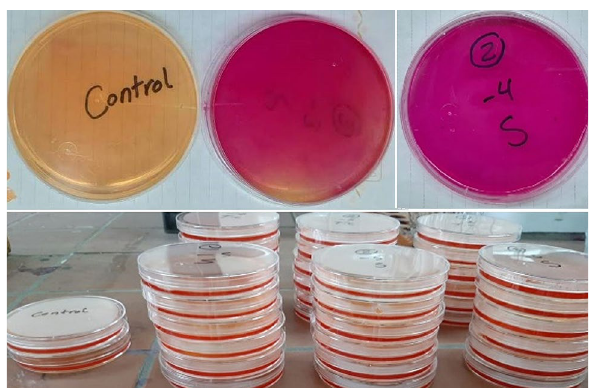
Figure 1. Qualitative urease activity on slants after 24 h of incubation (2%